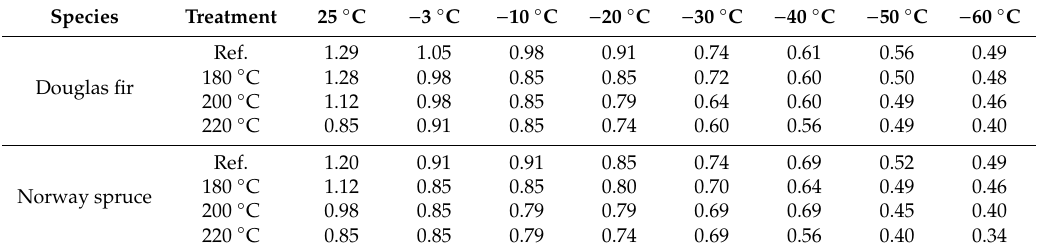
temperatures (unit: ms).